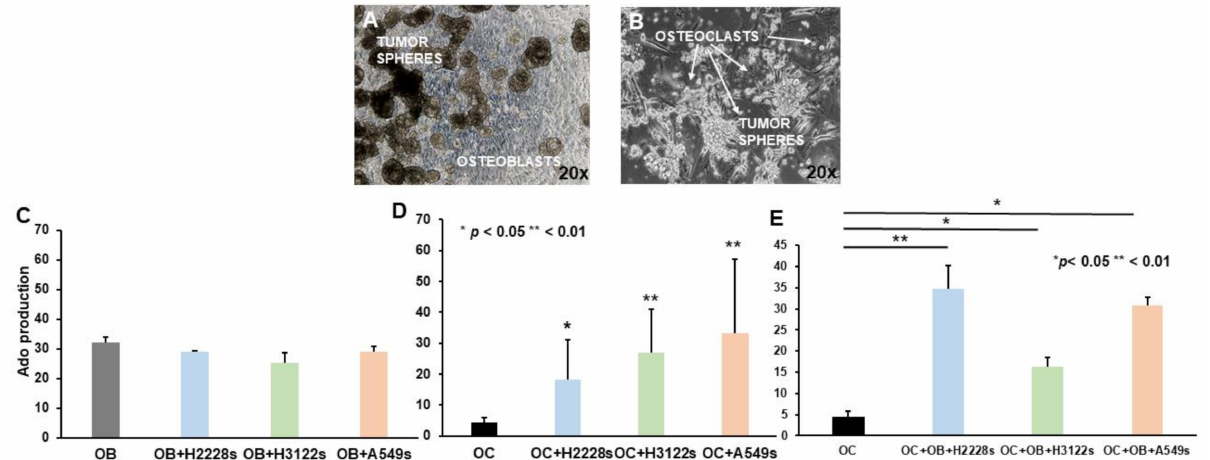
Figure 3. Ado production in co-cultures of NSCLC CSC spheres and bone cells. Representative images of NSCLC CSC spheres co-cultured with OBs ( A ) and OCs ( B ) are shown (magnification 20 × ). The graphs show the quantification of Ado production expressed as mean area % of the peaks ± SD, in the different culture settings ( C – E ). The differences in Ado production among the three types of CSC spheres, OBs, and OCs was analyzed by one-way Anova.